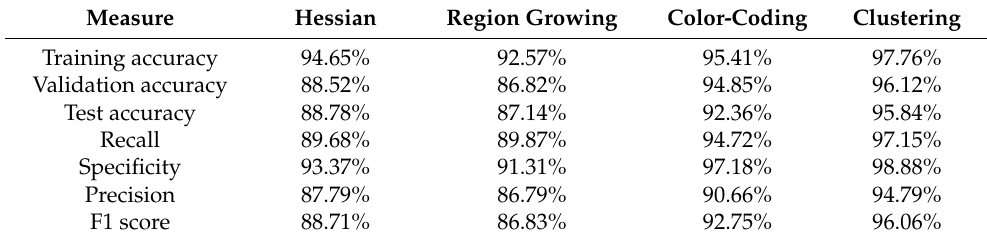
Table 3. Evaluation metrics of all methods with